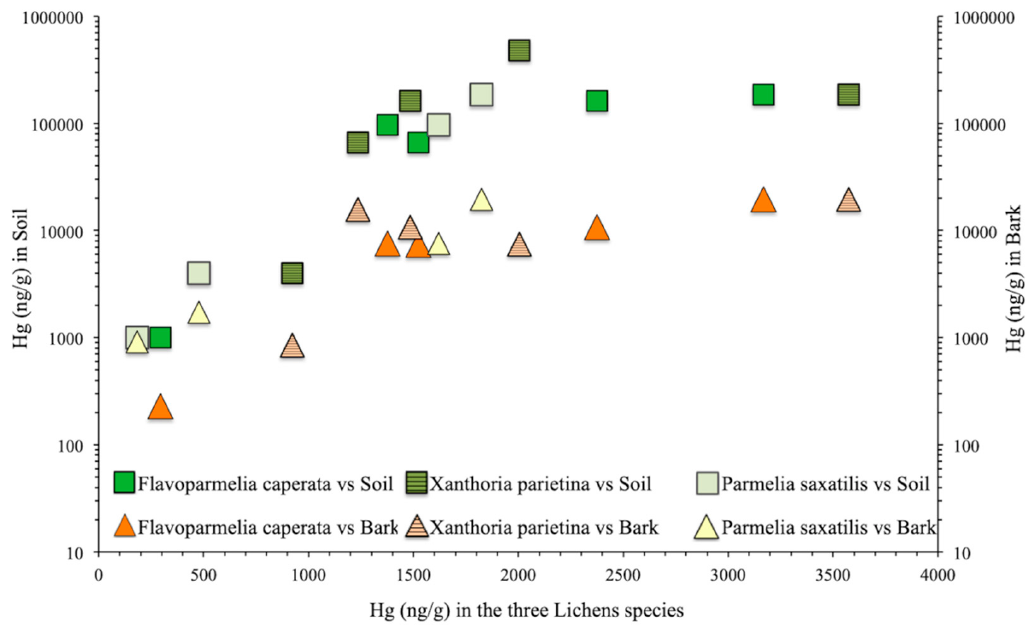
Figure 2. Correlation between Hg contents in lichens, barks, and soils.